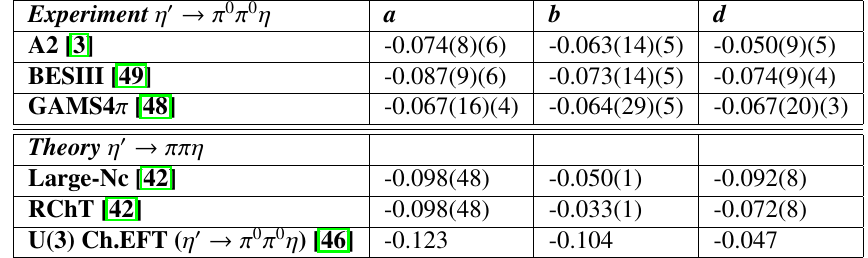
Table 1. Dalitz plot-parameter values for η (cid:48) → π 0 π 0 η with errors given in the parentheses. For the experimental data, the first and second parentheses denote the statistical and systematical errors,